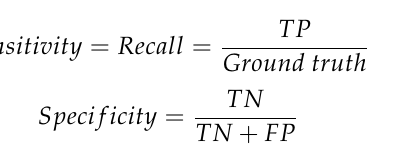
Table 3. Comparison of the two models.